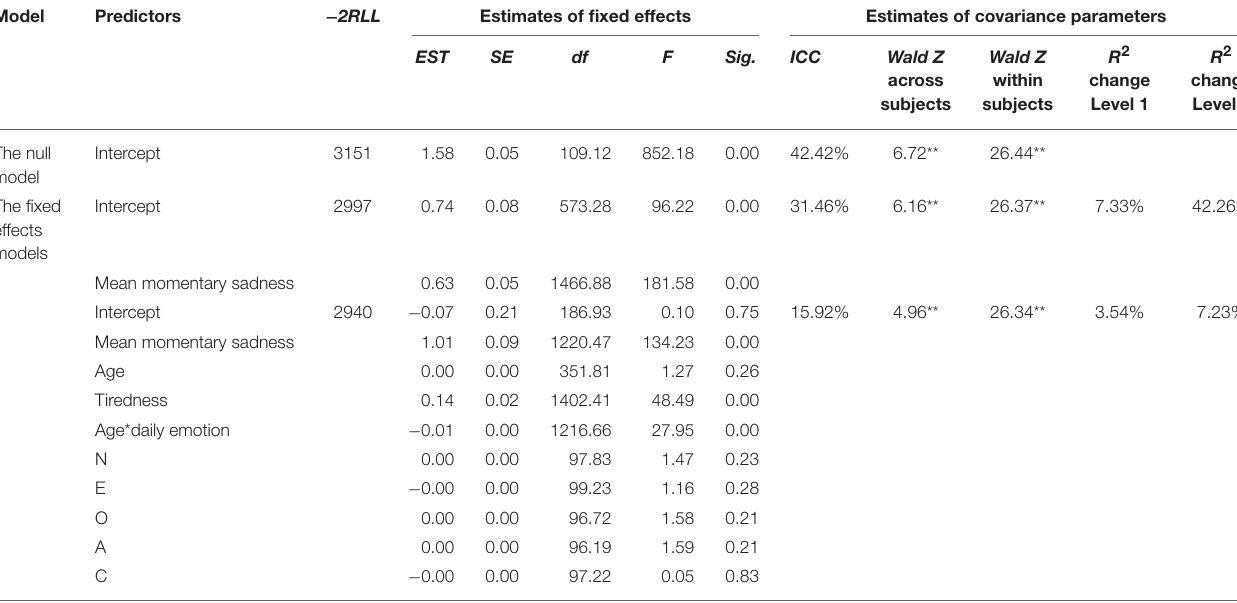
TABLE 3 | The evening ratings of sadness—results of the mixed models analysis of the null model and fixed effects random intercept model. Model